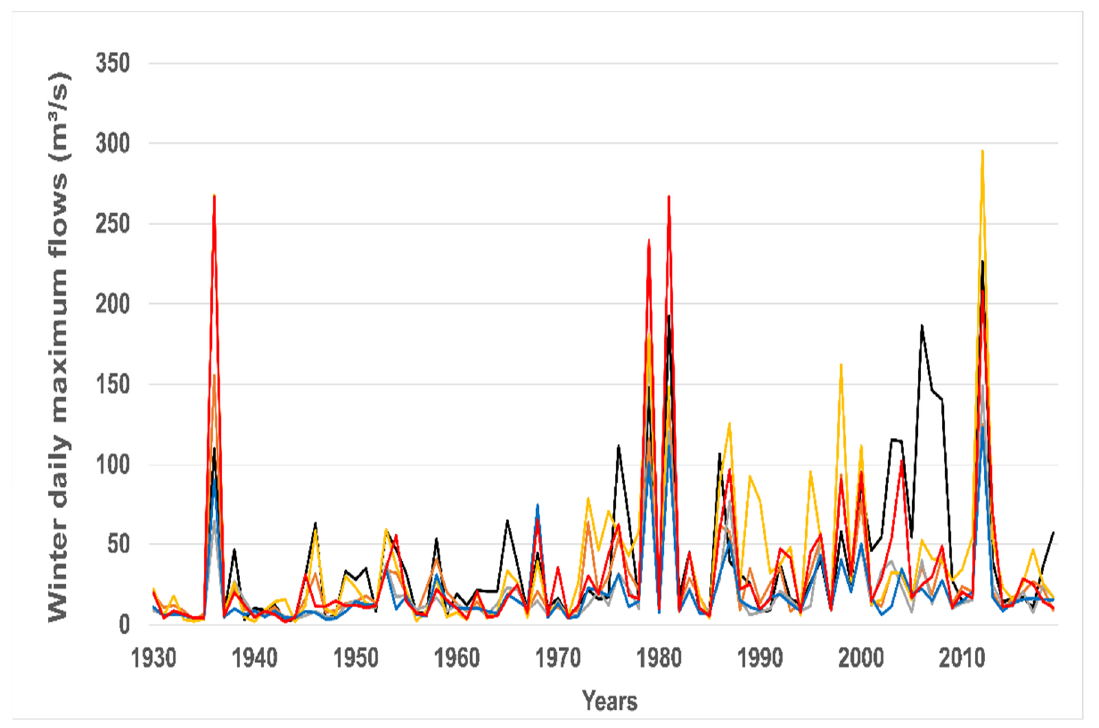
Figure 4. Interannual variability of winter daily maximum specific flows (l/s/km²) in the Eastern hydroclimatic region from 1930 to 2019. Ouelle River: yellow curve; Du Loup River: orange curve; Trois-Pistoles River: red curve; Rimouski River: blue curve; Matane River: grey curve; Blanche River: black curve.